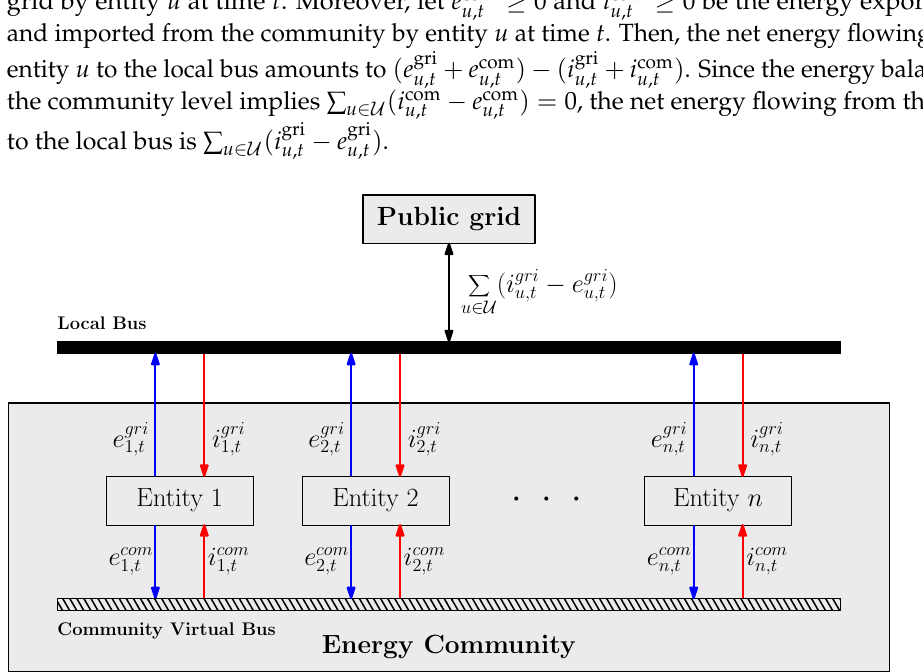
Figure 1. Energy flows in an energy community. Red arrows: imported energy; blue arrows: ex- ported